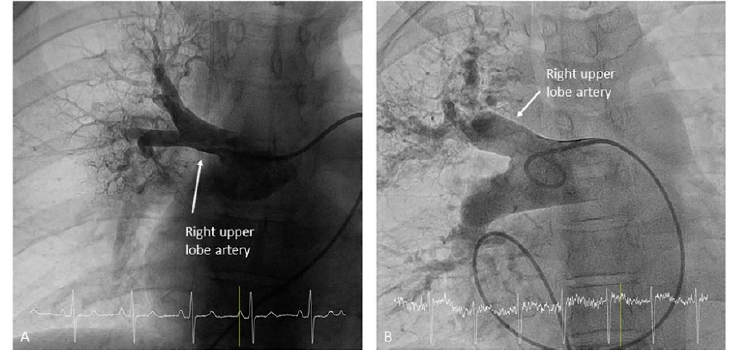
Figure 6. Right upper lobe artery (( A , B ): anteroposterior view).